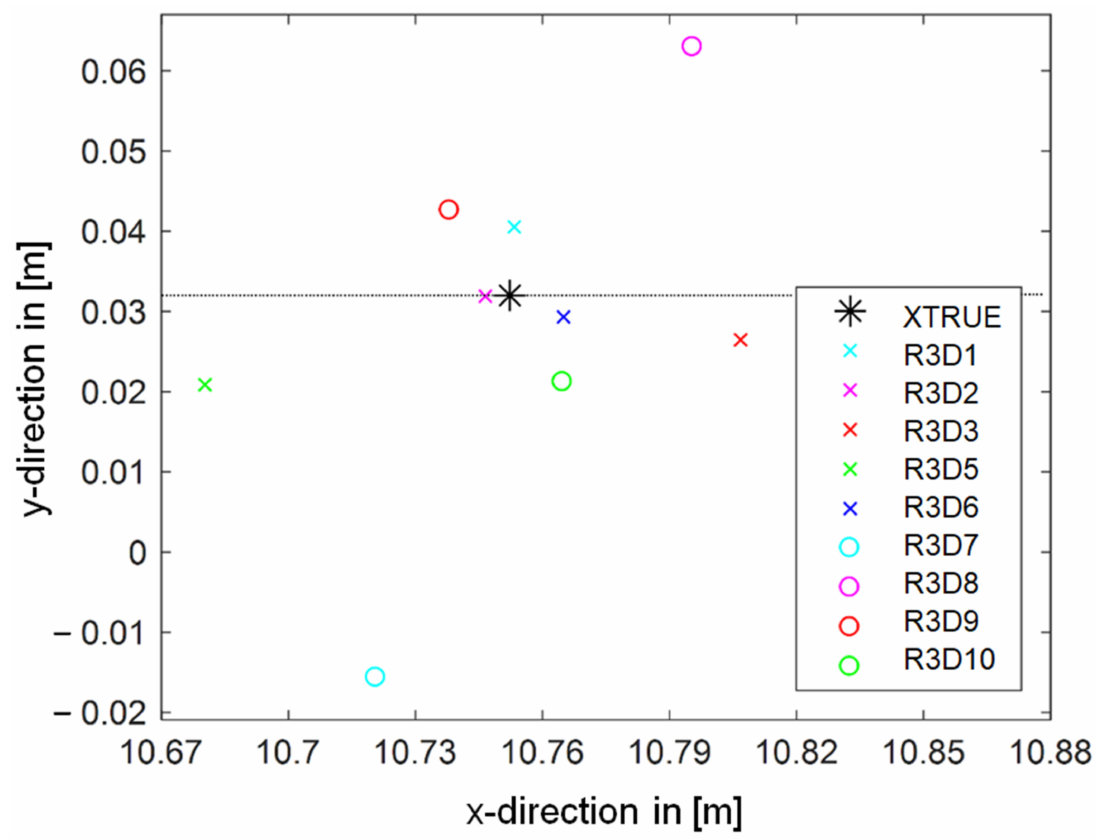
Figure 7. Selected 1-point zoom in target and single drive